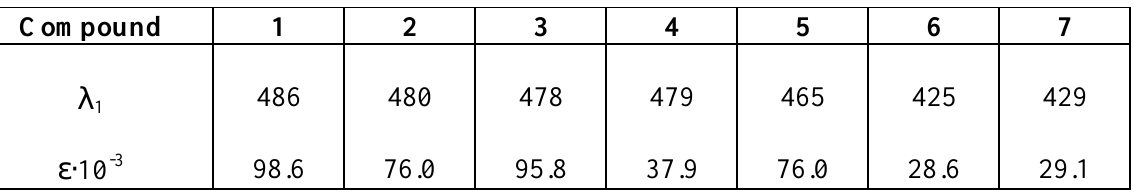
Table 1. Position ( l , nm) and intensities ( e(cid:215) 10 -3 ) of dipyrromethene hydrobromide absorption bands 1 in methylene